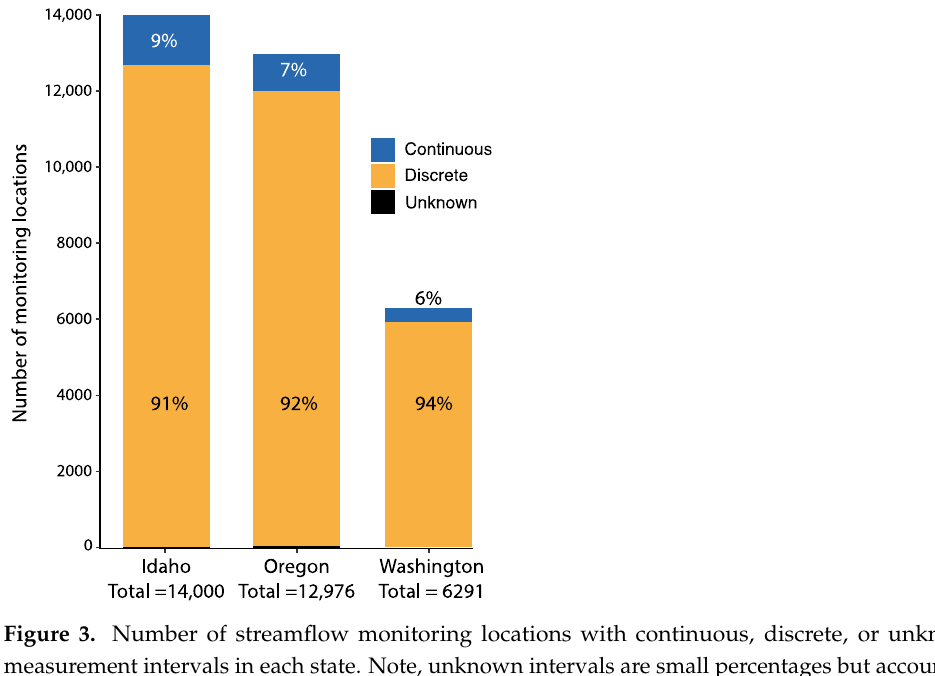
5 of 12 Figure 2. The Streamflow Data Catalog online visualization (https://tableau.usgs.gov/views/Stream ‐ flow_Catalog/Introduction (accessed on 3 Faburary 2023)) shows all of the sites in the catalog and provides users the ability to select and filter the sites based on available metadata. Circles represent each monitoring location in the dataset and are scaled to the length of the data record. Note that